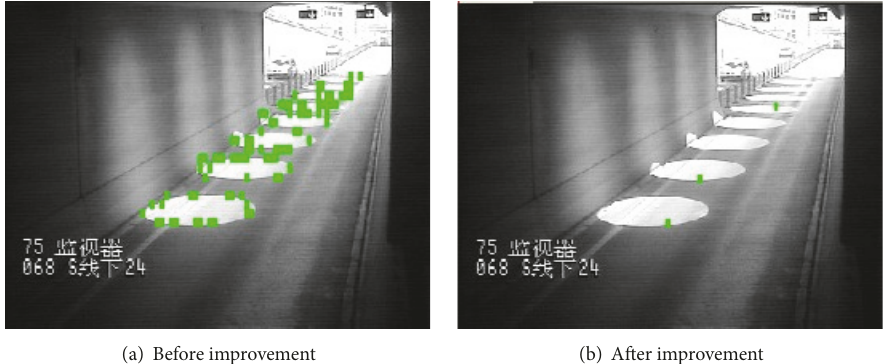
Figure 20: Comparison of the effects before and after the improvement of the algorithm for the entrance of Shanghai Fuxing Road Tunnel.